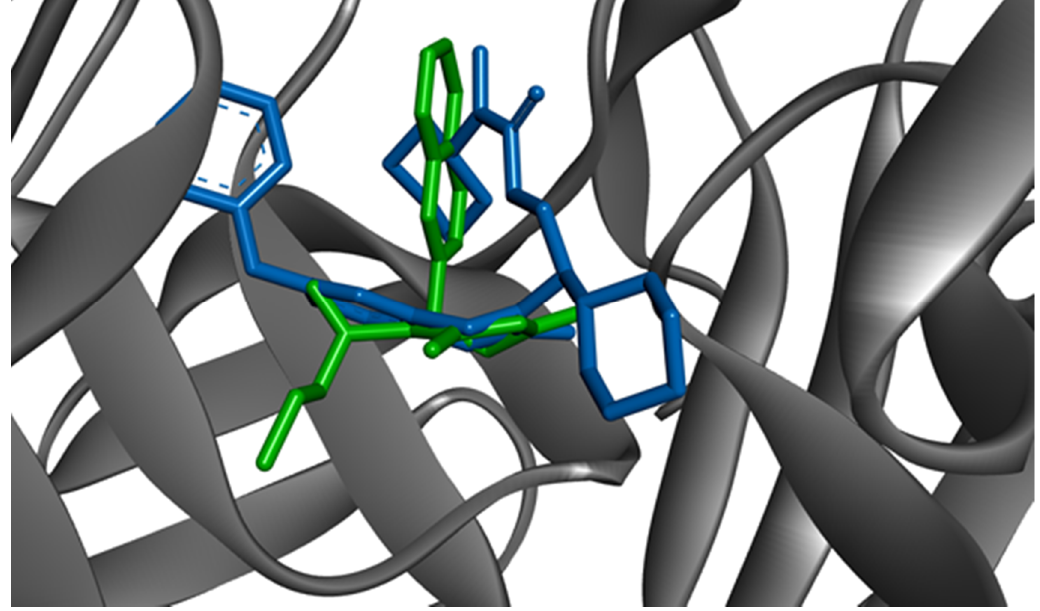
Figure 2. Overlay of the crystal structure of the complex of BACE-1 with the Baxter inhibitor (blue) and the best calculated pose of ( R )-10c (green). The dihydropyrimidine rings of the two inhibitors are nearly perfectly superimposed; the naphthyl group of ( R )-10c is superimposed to the terminal cyclohexyl group of Baxter inhibitor’s side chain and the ester group is partially superimposed to the fused benzene